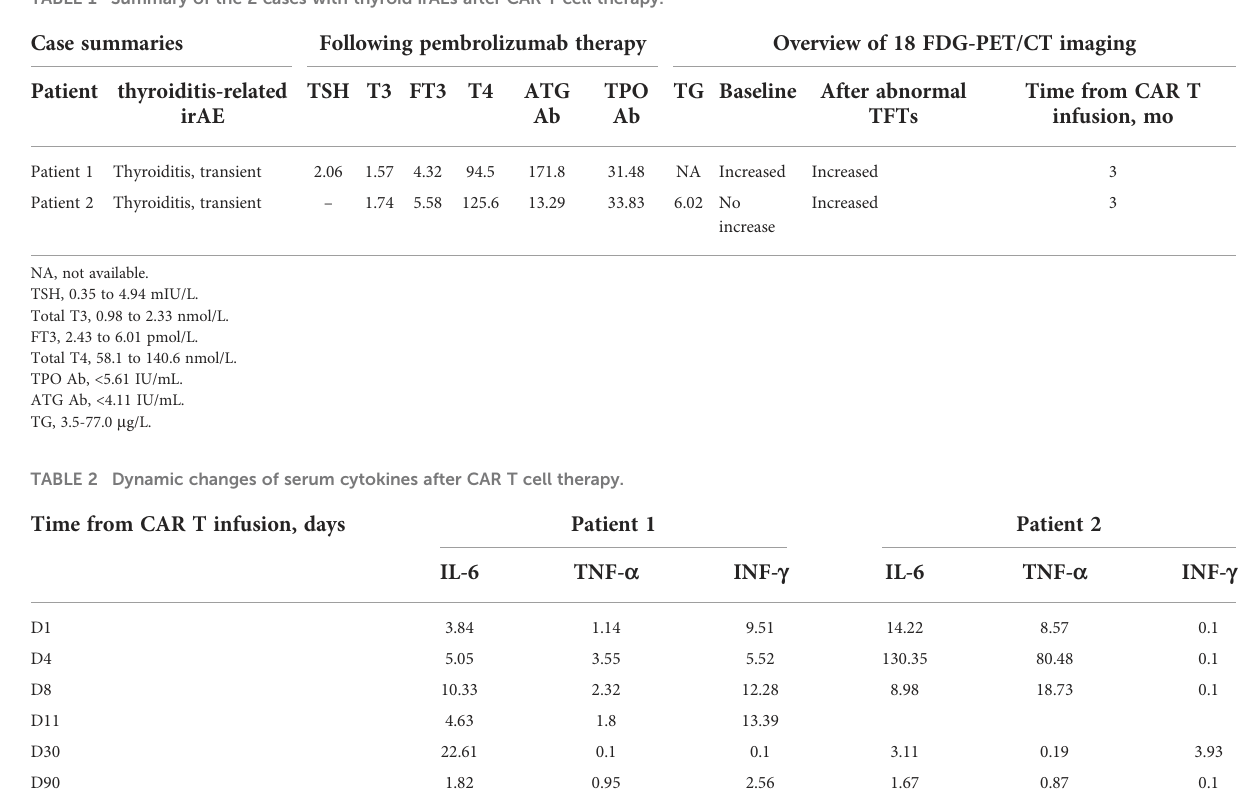
TABLE 1 Summary of the 2 cases with thyroid irAEs after CAR T cell therapy.